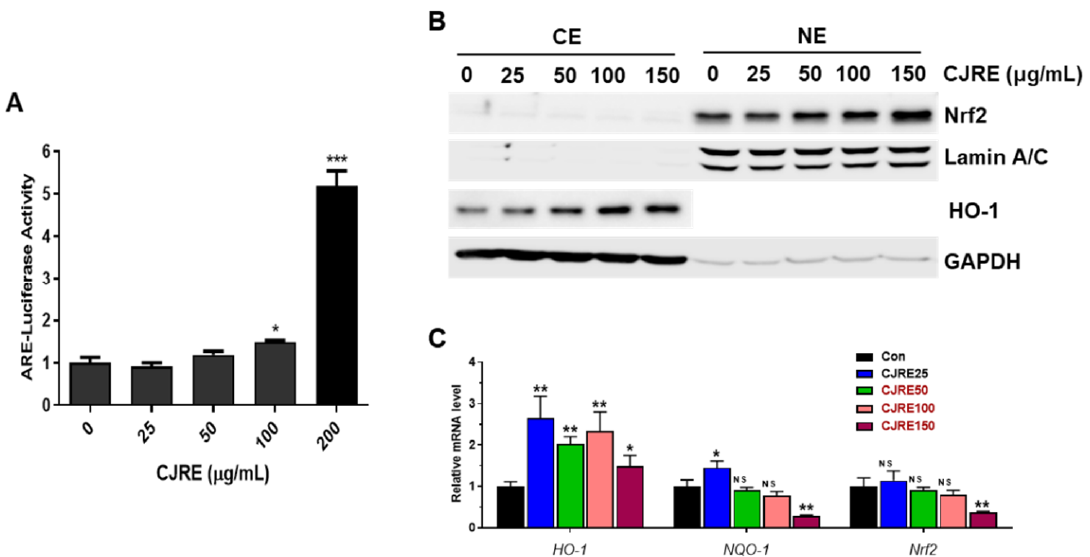
Figure 1. CJRE increases the NRF2 activity in HeLa cells. ( A ). ARE-luciferase activity was measured after treatment with various doses of CJRE for 12 h in HeLa cells. ( B ). The cells were treated with various doses of CJRE for 24 h and Western blotting was performed. ( C ). qPCR data showed the different mRNA levels of HO-1 , NQO -1, and NRF2 after treatment with different doses of CJRE for 24 h. * p < 0.05; ** p < 0.001; *** p < 0.0001; NS, not significant.